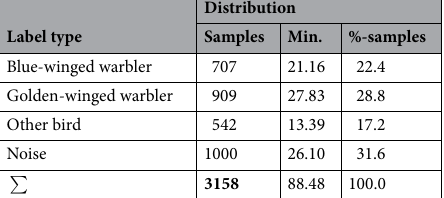
Table 2. Blue-/golden-winged warbler data distribution. Significant values are in bold.